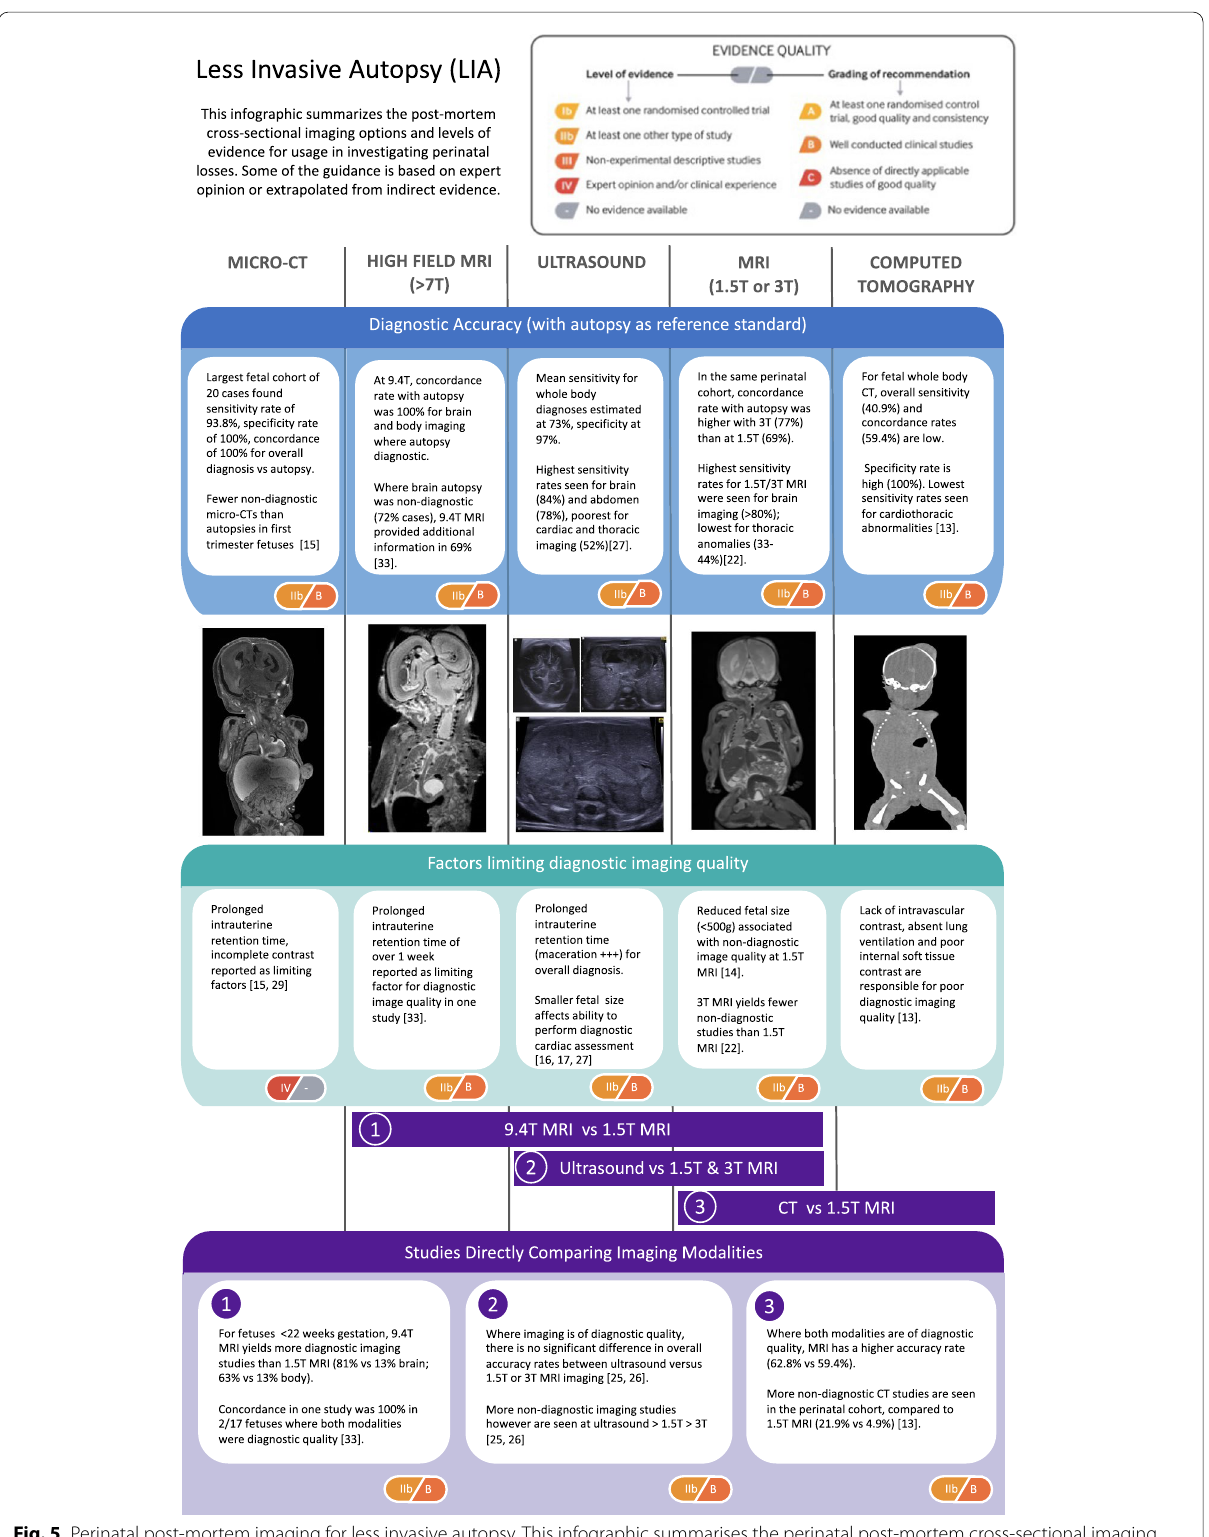
Fig. 5 Perinatal post-mortem imaging for less invasive autopsy. This infographic summarises the perinatal post-mortem cross-sectional imaging options and levels of evidence for their